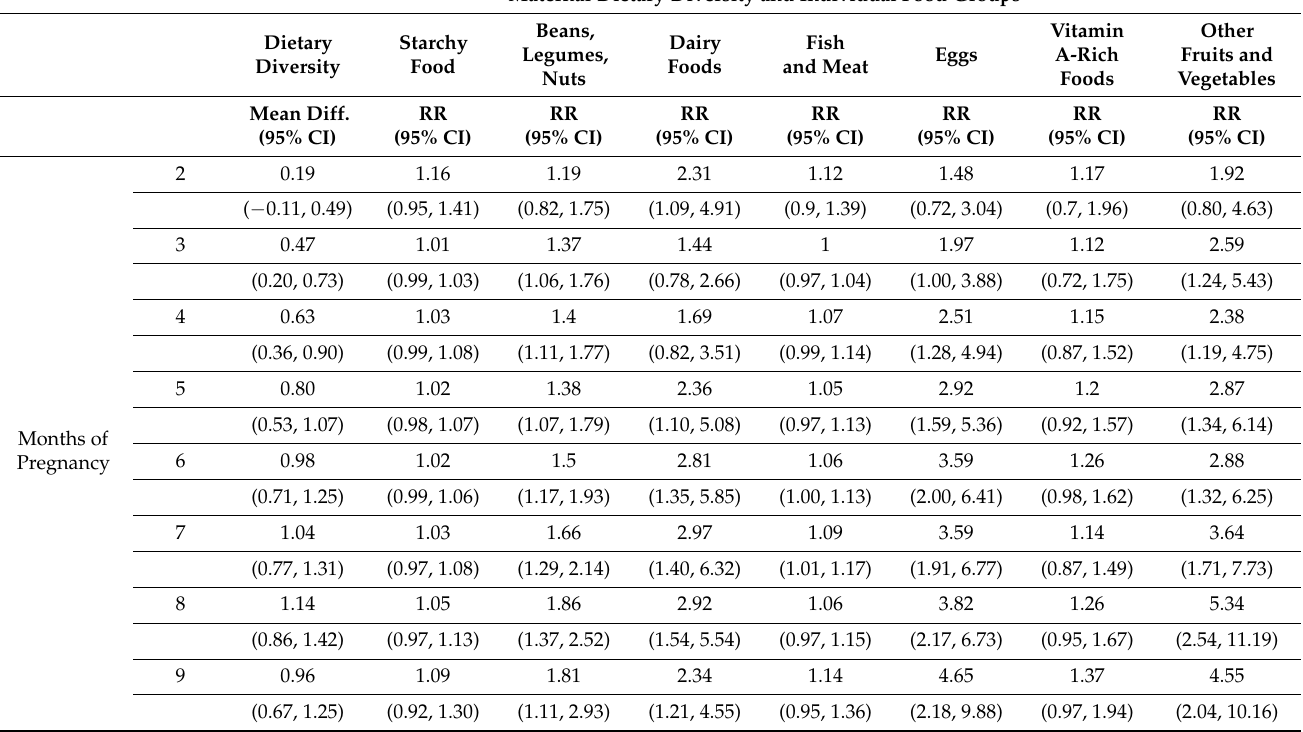
Table 4. Effect of balanced plate nutrition education intervention on maternal dietary diversity and individual food groups. Maternal Dietary Diversity and Individual Food Groups Beans, Vitamin Other Dietary Starchy Dairy Fish Legumes, Eggs A-Rich Fruits and Diversity Food Foods and Meat Foods